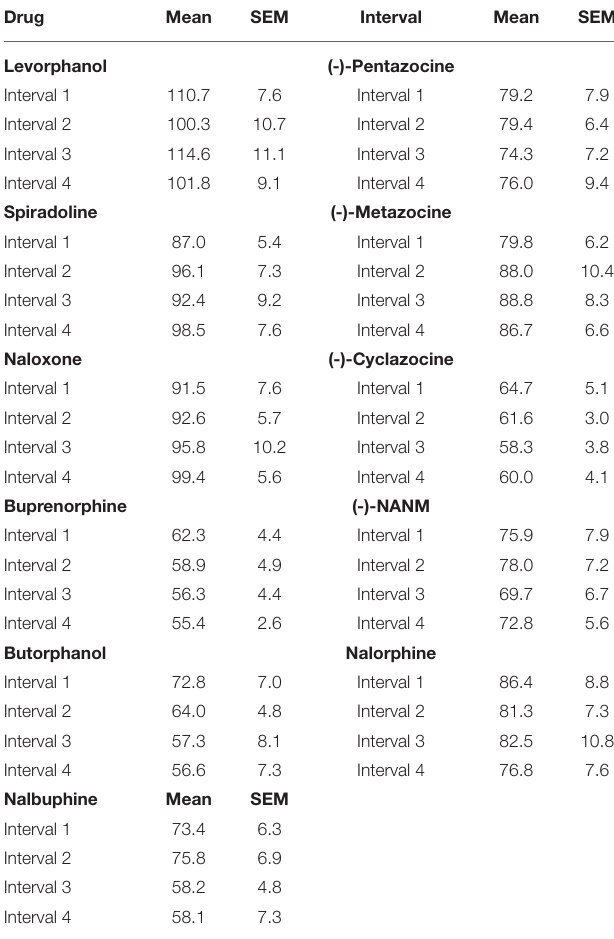
TABLE 1 | Raw locomotor activity counts under non-injection control